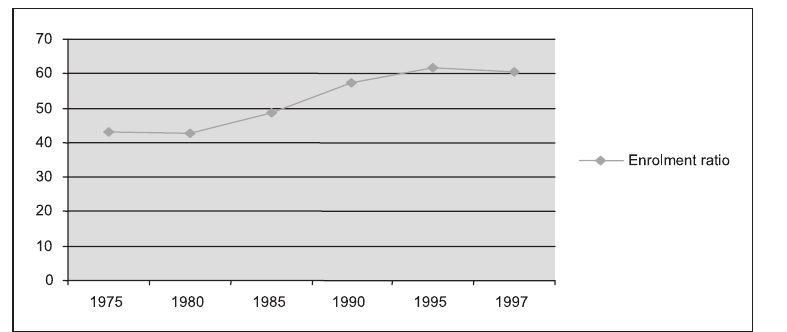
Figure 12. Enrolment